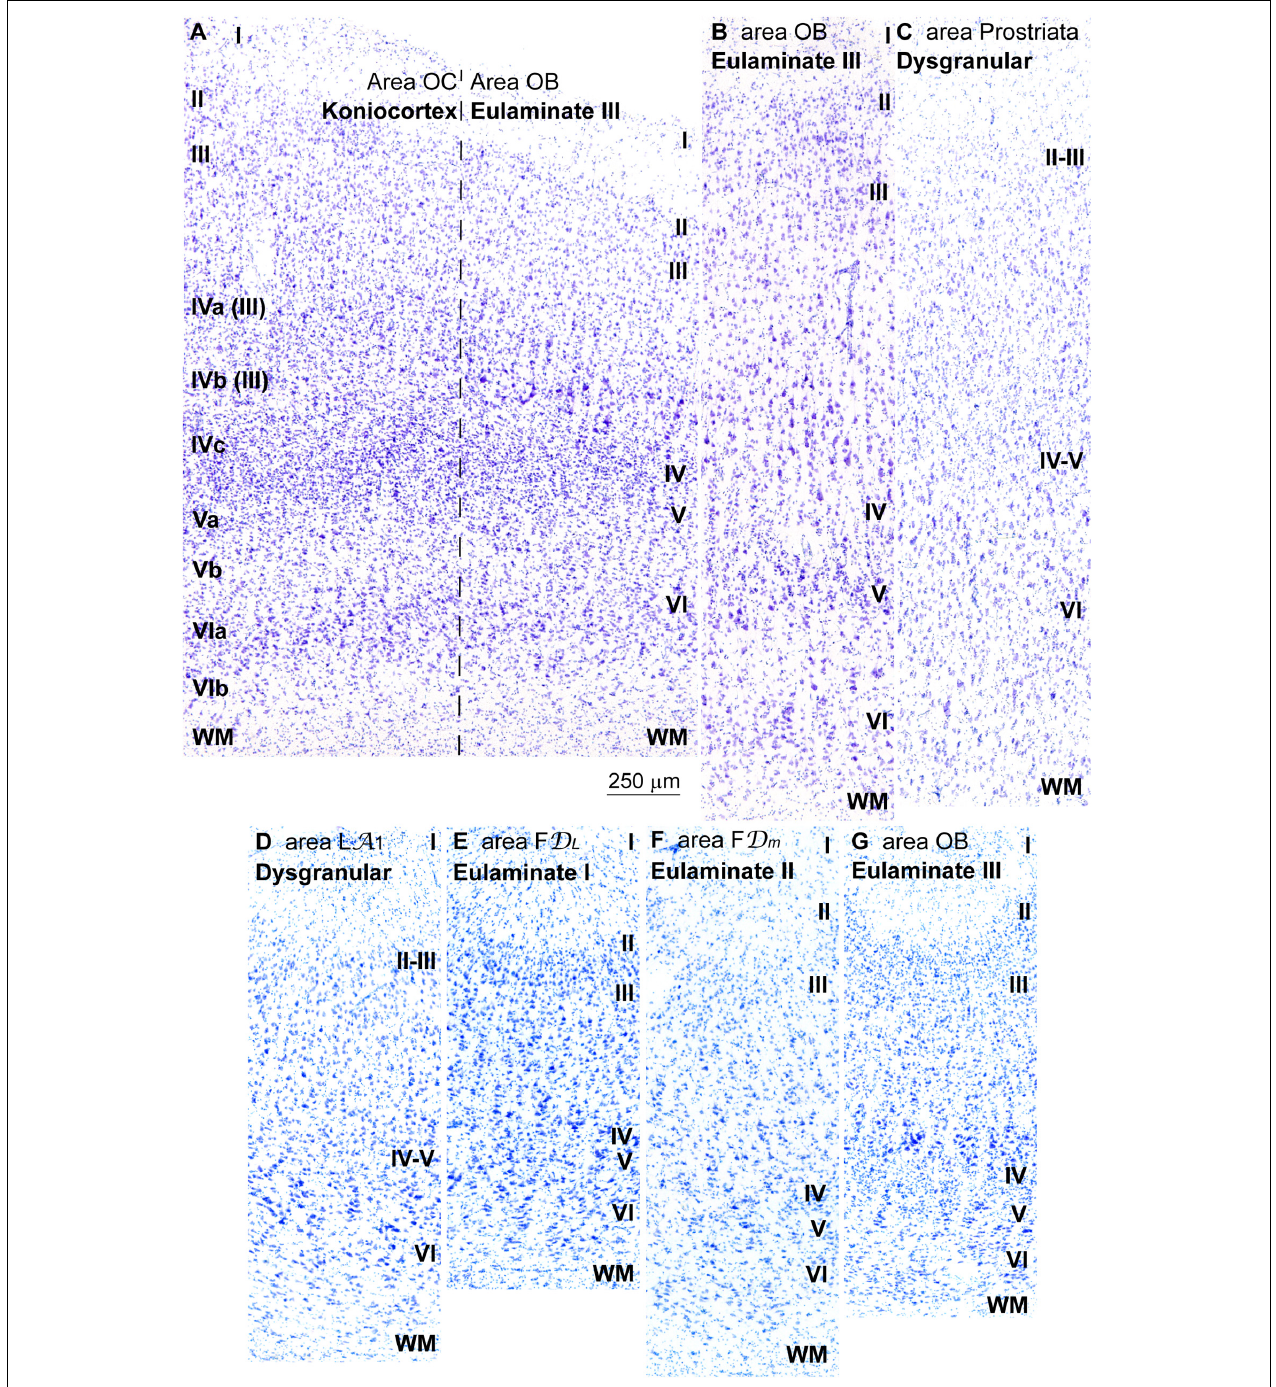
FIGURE 7 | Laminar variation of koniocortical and parakoniocortical areas in the occipital lobe in Nissl stained sections and in sulcal parts of prefrontal and occipital areas. (A) , Micrograph of the transition between the primary visual area (area OC, left) and the secondary visual area (area OB, right) in Nissl stained section; roman numerals on the left indicate layers of area OC; roman numerals on the right indicate layers of area OB. It must be considered that the most widely used laminar nomenclature for area OC labels the deepest part of layer III as layers IVa and IVb [note that in the laminar nomenclature of Brodmann (1909/1999) parts of layer III are labeled as IVa and IVb (Hassler, 1966)] only layer IVc is comparable to layer IV in other areas; layers IVa and IVb are part of layer III and contain projection neurons. (B) , Micrograph of area OB in a remote sector from area OC in Nissl stained section. (C) , Micrograph of area prostriata in Nissl stained section. (D–G) , Micrographs of the sulcal parts (fundus) of Dysgranular area LA 1 (D) , Eulaminate I area FD L (E) , Eulaminate II area FD m (F) , and Eulaminate III area OB (G) . The areas according to the Atlas of von Economo and Koskinas (1925/2008) and the cortical type are indicated in each micrograph; see the text for description of laminar features. WM, white matter. Roman numerals indicate cortical layers. Calibration bar in (A) applies to (A–G) .